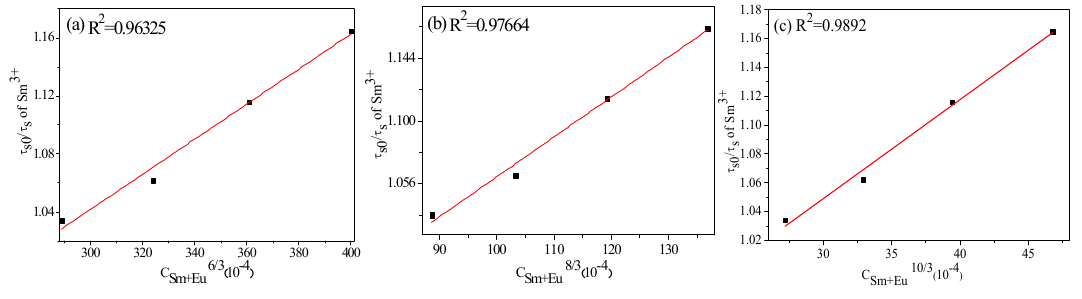
Figure 10. Dependence of τ s0 / τ s on C α /3 with α = ( a ) 6, ( b ) 8, ( c ) 10.